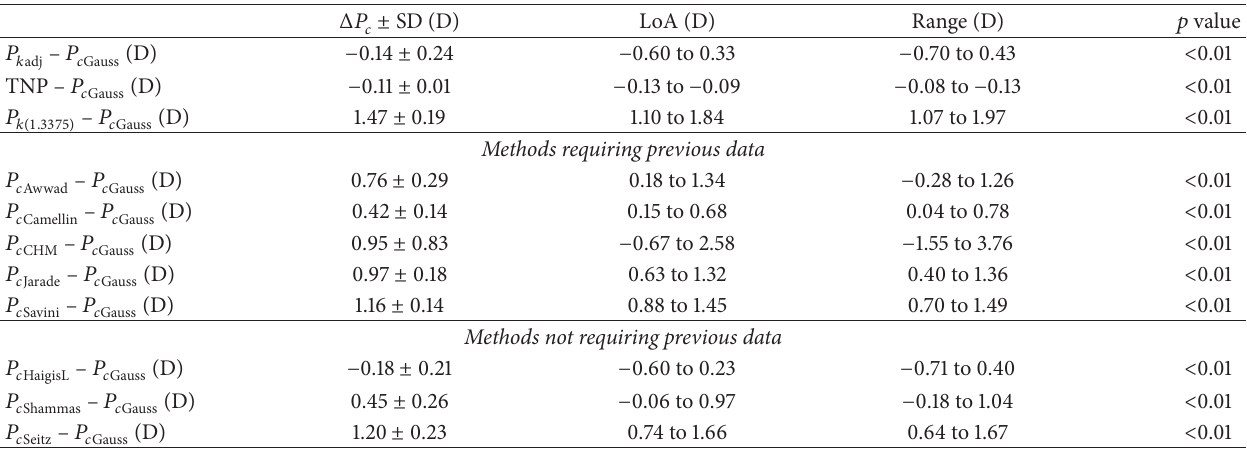
and the corneal power obtained with other methods. Gauss